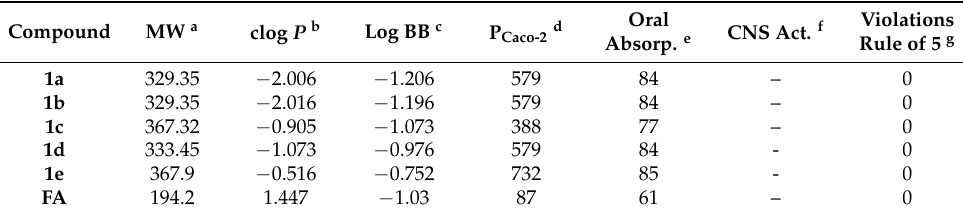
Table 4. Physicochemical descriptors and ADME properties of tested compound 1(a – e) calculated by QIKPROP v. 2.5